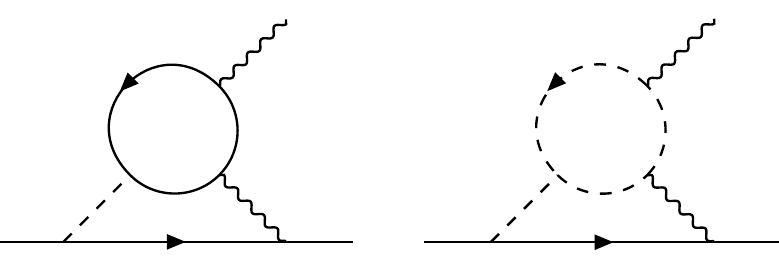
Figure 2 . The Barr-Zee type diagrams including the fermion loop (left) and the scalar loop (right).